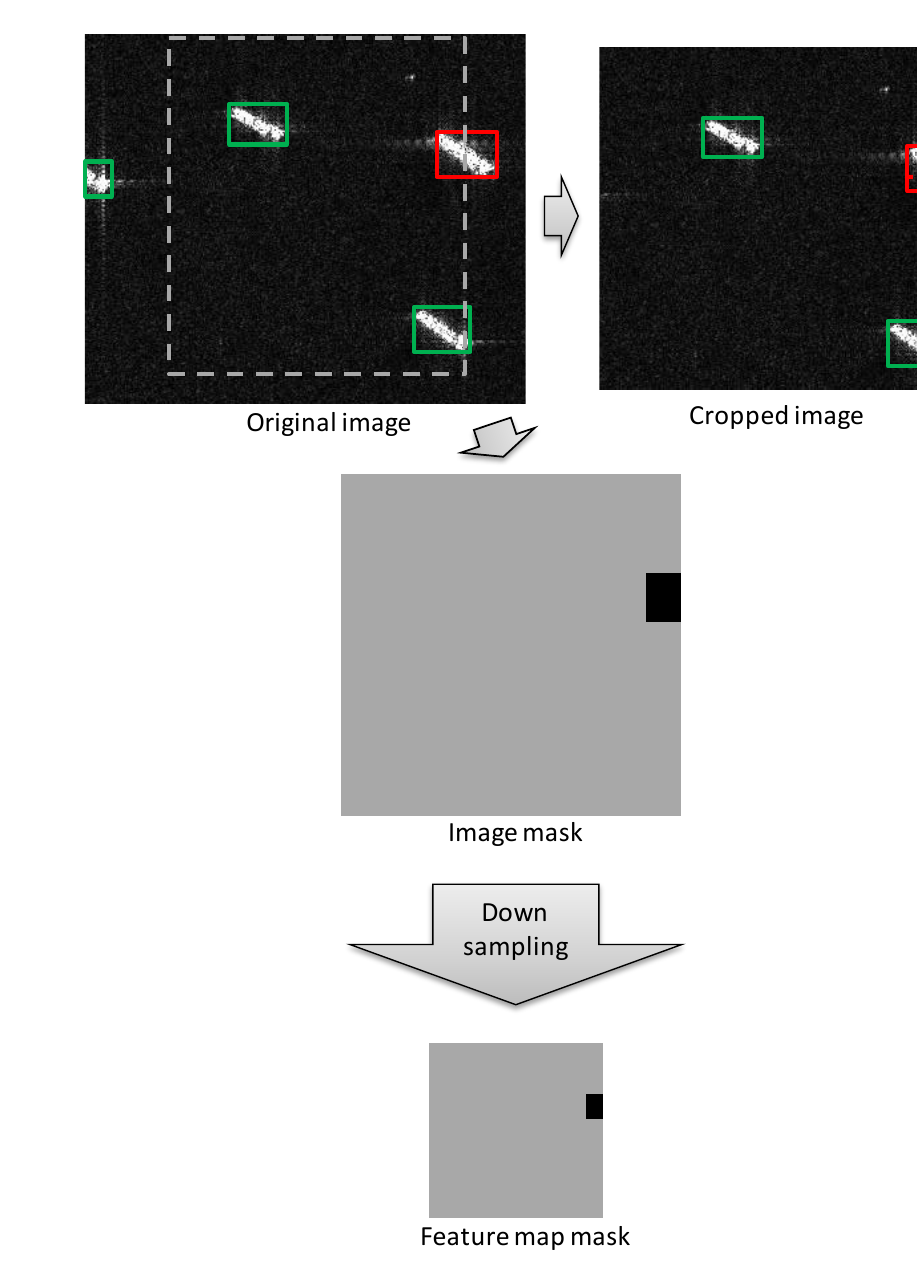
Figure 5. Image slice and its corresponding feature map mask.